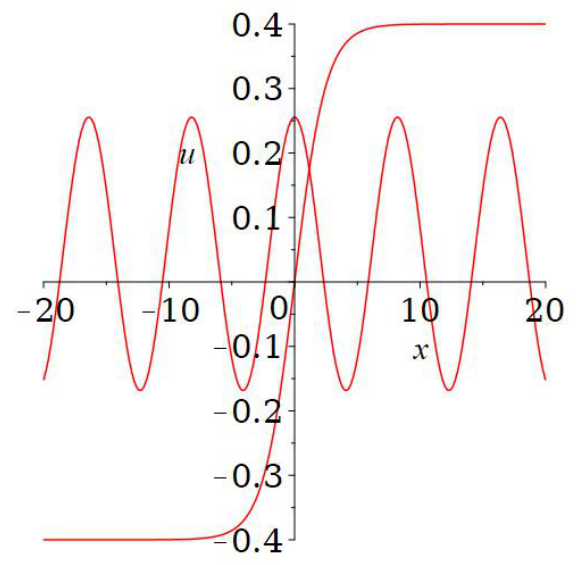
Figure 3. Plot of separate state for one kink soliton or the cnoidal wave expressed by ( 10 ) and ( 15 ) of the nonlocal mKdV equation at t =